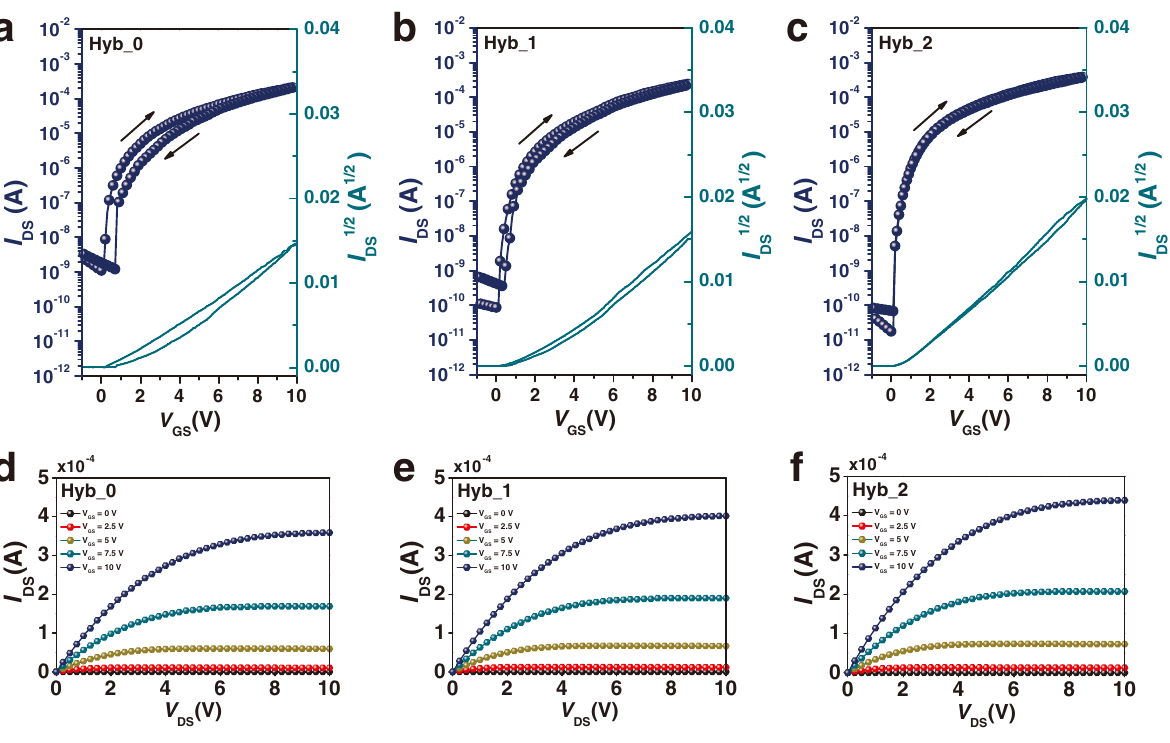
Fig. 4 | Current – voltage characteristics of In 2 O 3 /ZnO heterojunction TFTs. Representative transfer characteristics of the TFTs with a Hyb_0, b Hyb_1, and c Hyb_2 as gate dielectrics, measured at V D =10V. Output characteristics of